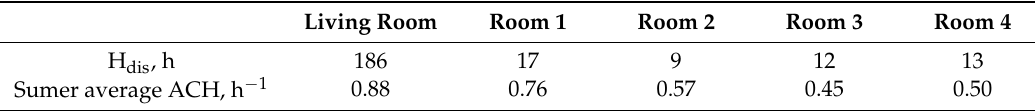
Table 5. H dis for case 1-UP (utopia point